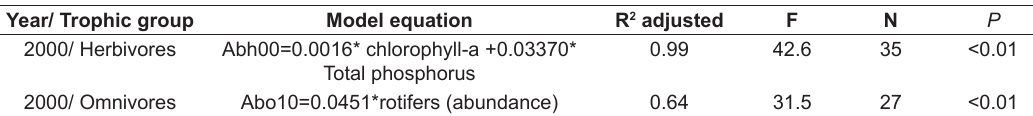
Table 4. Summary of covariance analysis between abundance of herbivorous copepods and environmental variables.